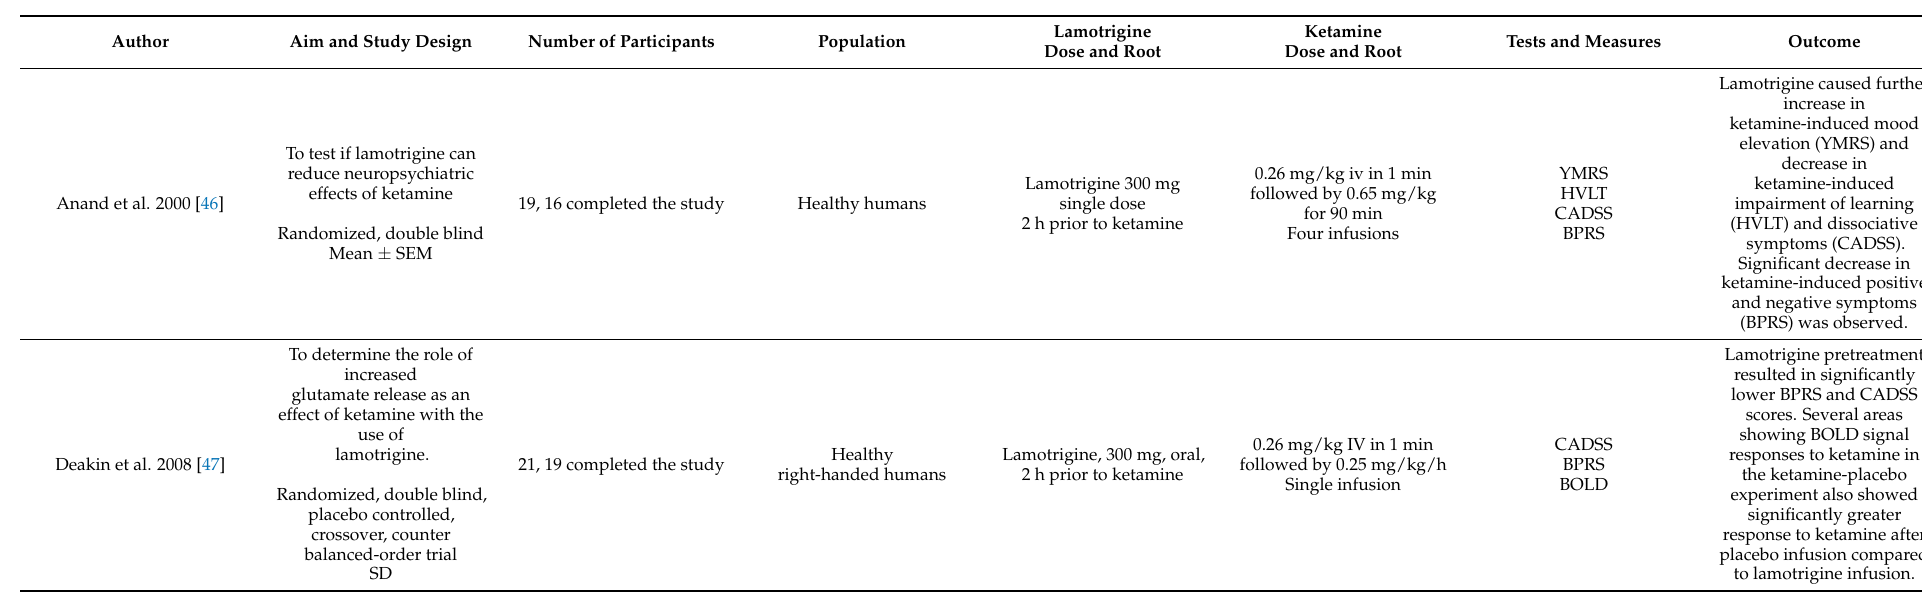
Table 2. Human studies on healthy